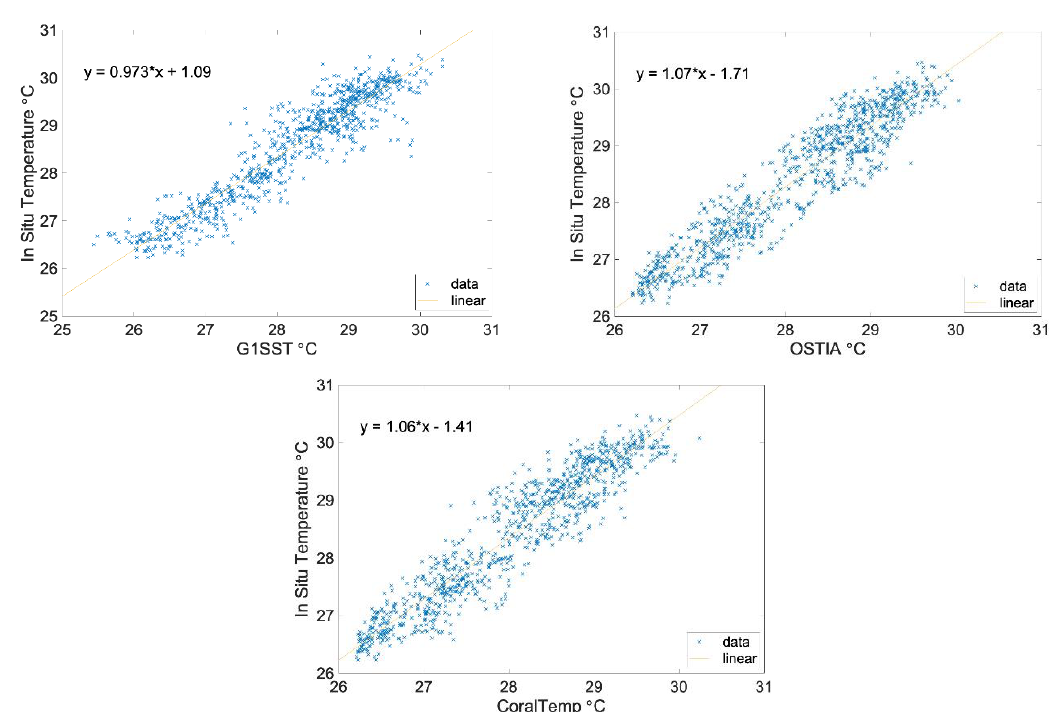
Figure 8. Scatter plots with linear regression of the averaged in situ temperature against the different three different remote sensing SST datasets for Cayo Enrique and Cayo Mario. J. Mar. Sci. Eng. 2020 , 8 , x FOR PEER REVIEW